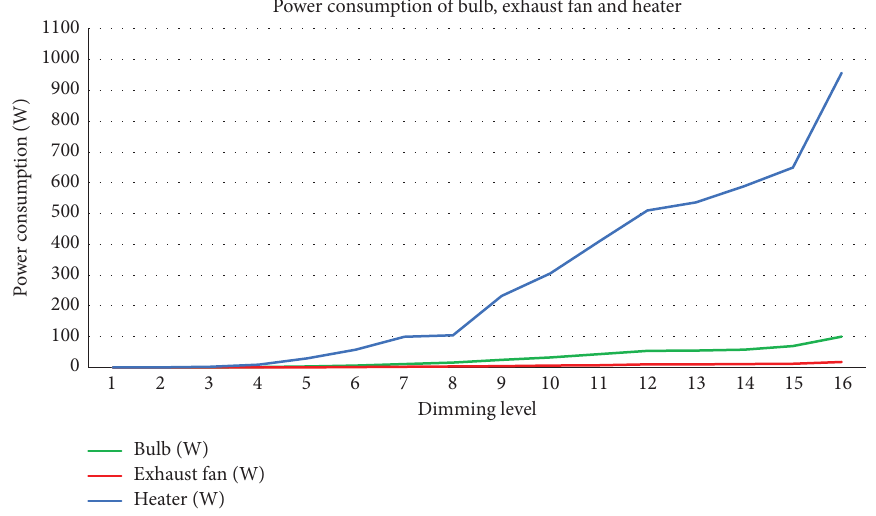
Figure 14: Power consumed by 100W bulb, 18W fan, and heater.